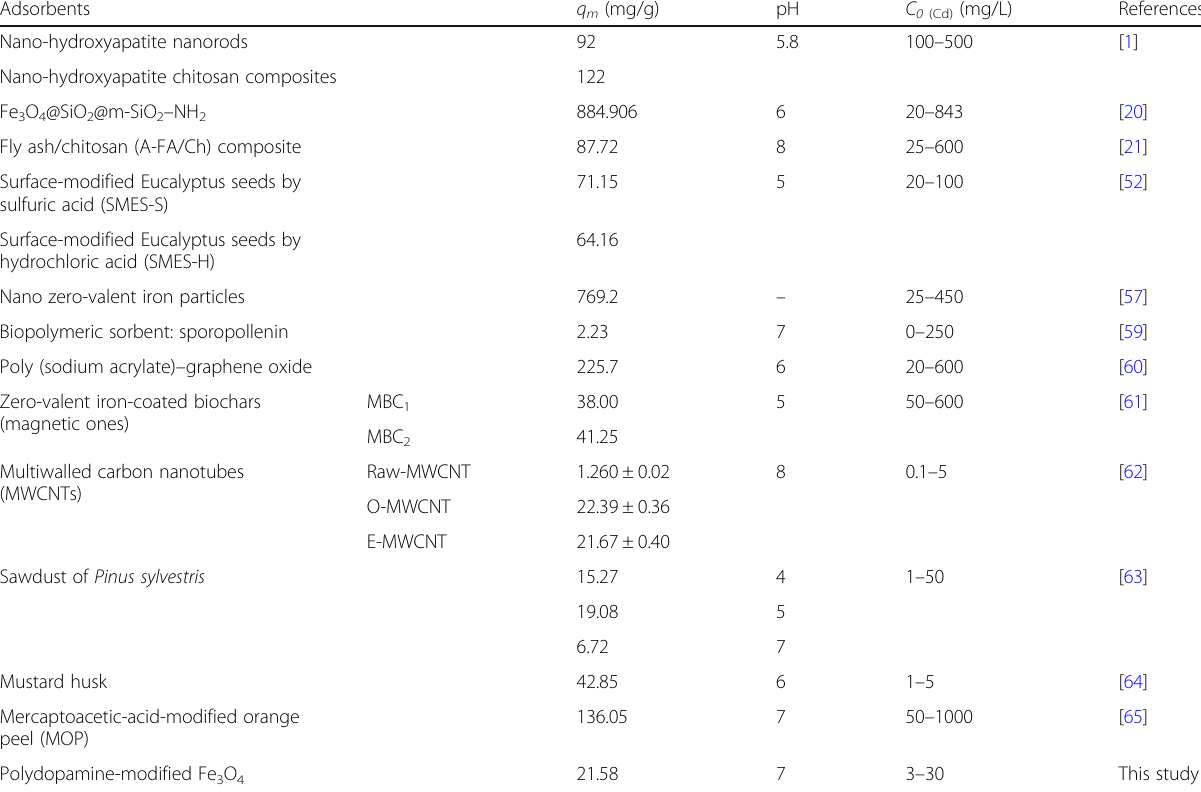
Table 3 Comparison of the maximum adsorption capacities of Fe 3 O 4 @PDA with some adsorbents cited in the literature Adsorbents